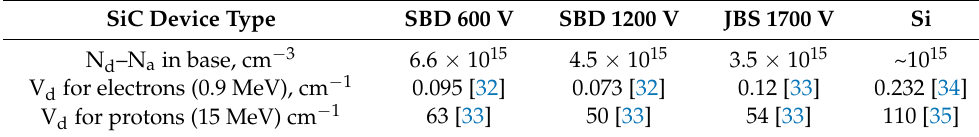
Table 1. Comparison of carrier removal rates in devices based on SiC and Si.